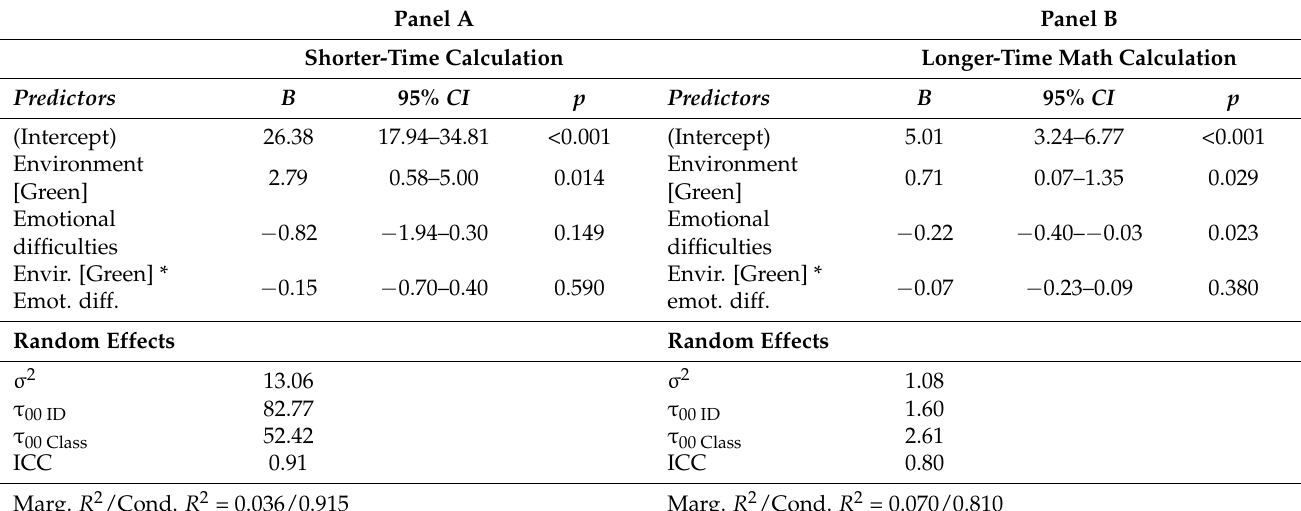
Table 3. Linear mixed models for shorter and longer ‐ time math calculation tasks. Panel A